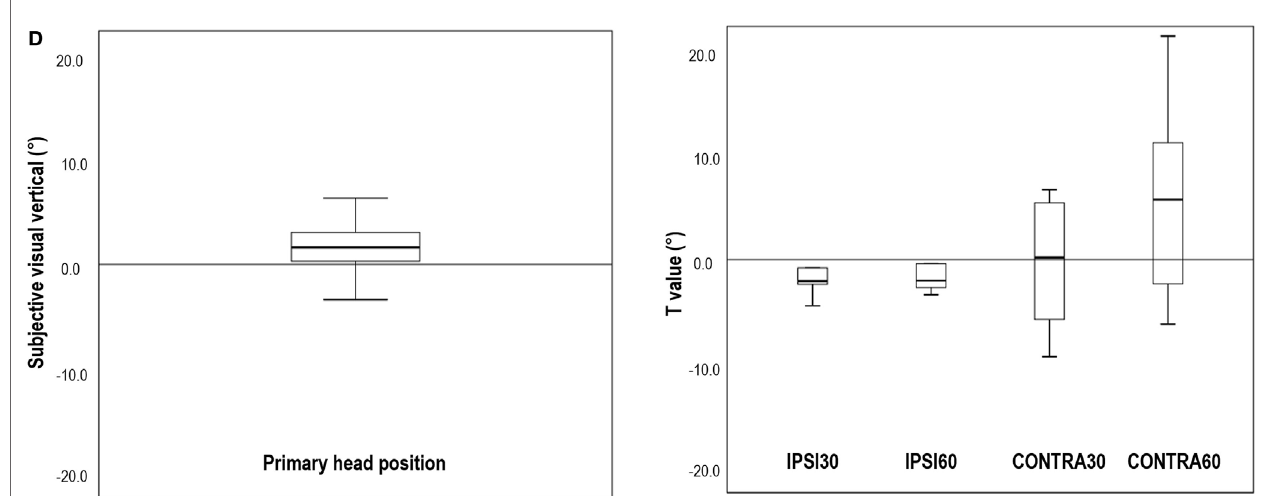
FigUre 1 | Subjective visual vertical (SVV) in the primary head position and shifts of the SVV induced by head tilts in normal participants and patients. (a) In normal subjects, the mean SVV was − 0.01 ± 1.20° with the head upright. Head tilts 30° slightly shifted the SVV in the opposite direction of head tilts (E-effect). During head tilts 60°, the shifts of SVV directed toward the head tilted side, resulting in positive T values (A-effect). (B) In patients with unilateral vestibular neuritis (VN), the SVV in the primary head position was tilted to the lesion side, and head tilts induced shifts of SVV in the direction of head tilts, larger during the contralesional head tilts. (c) In patients with lateral medullary infarction (LMI), the SVV in the primary head position was also tilted to the lesion side. Patients with LMI showed negative T values during ipsilesional head tilts, indicating the shift of SVV into the contralesional direction, but showed positive T values during contralesional head tilts. (D) Patients with compensated VN exhibited SVV within the normal range in the upright head position and showed the similar T values obtained during head tilts when compared with controls, although the SDs of the T values were larger than those of normal subjects. RED30, head tilts 30° with right ear down; RED60, head tilts 60° with right ear down; LED30, head tilts 30° with left ear down; LED60, head tilts 60° with left ear down; IPSI30, head tilt 30° to the ipsilesional side; IPSI60, head tilt 60° to the ipsilesional side; CONTRA30, head tilt 30° to the contralesional side; CONTRA60, head tilt 60° to the contralesional side. Note: In normal controls, a positive value of SVV indicates rightward tilt from the subject’s perspective. In patients, the SVV was defined positive when the tilt is toward the lesion side. The shift in SVV induced by head tilts ( T value) was obtained by subtracting the SVV in the primary head position from the SVV in each head tilted position. In both normal controls and patients, T value was defined to be negative when the shift is in the opposite direction of head tilt. When the shift was in the same direction of head tilt, T value was defined to be